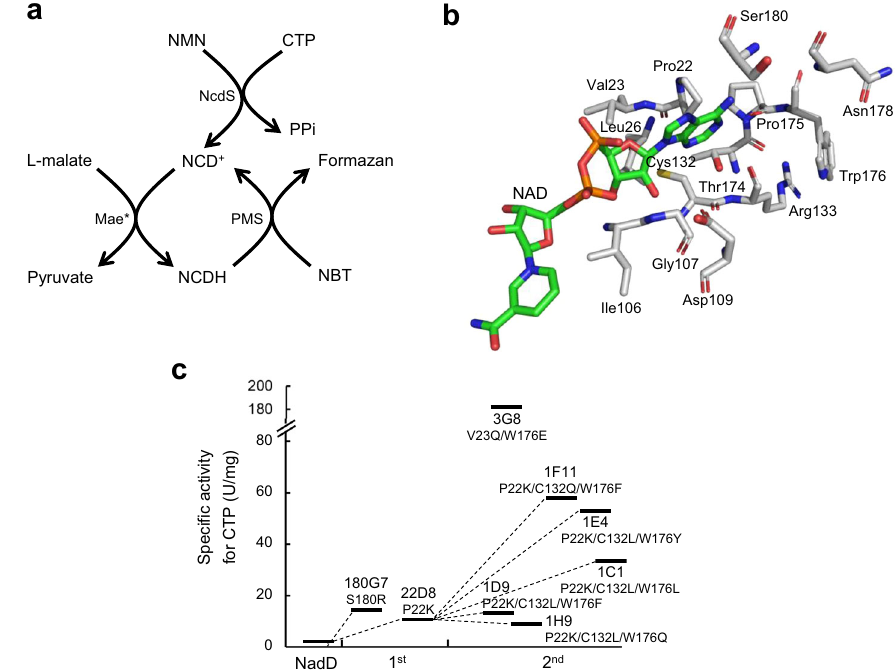
Fig. 2 Directed evolution of NadD for NCD biosynthesis. a The principle of coupled colorimetric assay for NCD formation. The expected NCD synthesis activity converts CTP and NMN into NCD, and an NCD-dependent malic enzyme mutant Mae* is used to convert NCD into NCDH, which reduces NBT into formazan in the presence of PMS. b The ATP-binding domain of E. coli NadD (PDB ID: 1K4M). NAD and targeted amino acids in NadD are shown in stick mode. Blue, nitrogen; red, oxygen; orange, phosphorus; yellow, sulfur; gray, carbon in NadD; green, carbon in NAD. c The evolutionary tree of NadD for CTP preference in two rounds of mutagenesis and